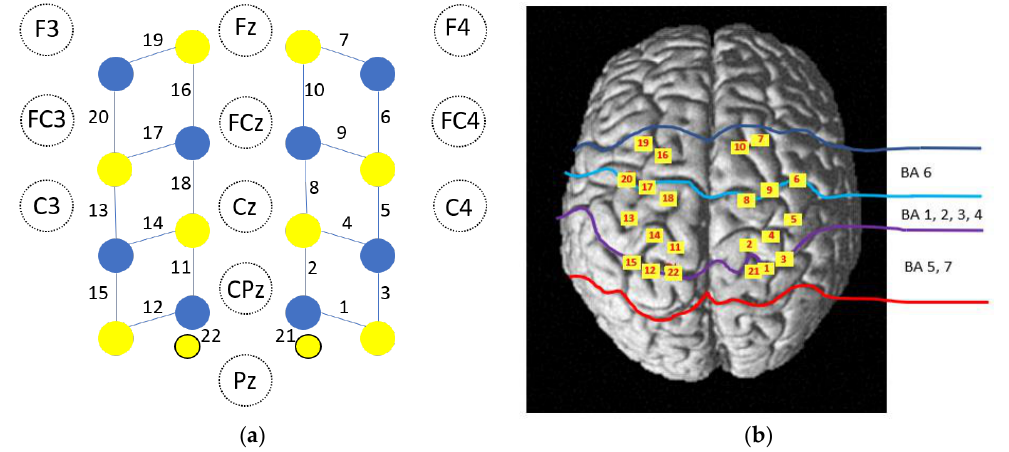
Figure 2. Position of the optodes. Schematics of the optode locations among the EEG 10/20 system. ( a ) A total of 18 optodes, including 10 light source (in yellow) and 8 detectors (in blue), were ar- ranged on the scalp to enable 20-channel measurement. There were two additional short channels (CH21 and CH22). ( b ) The anatomical locations of the optodes were superimposed onto the normal- ized brain surface in the MNI standard brain template.